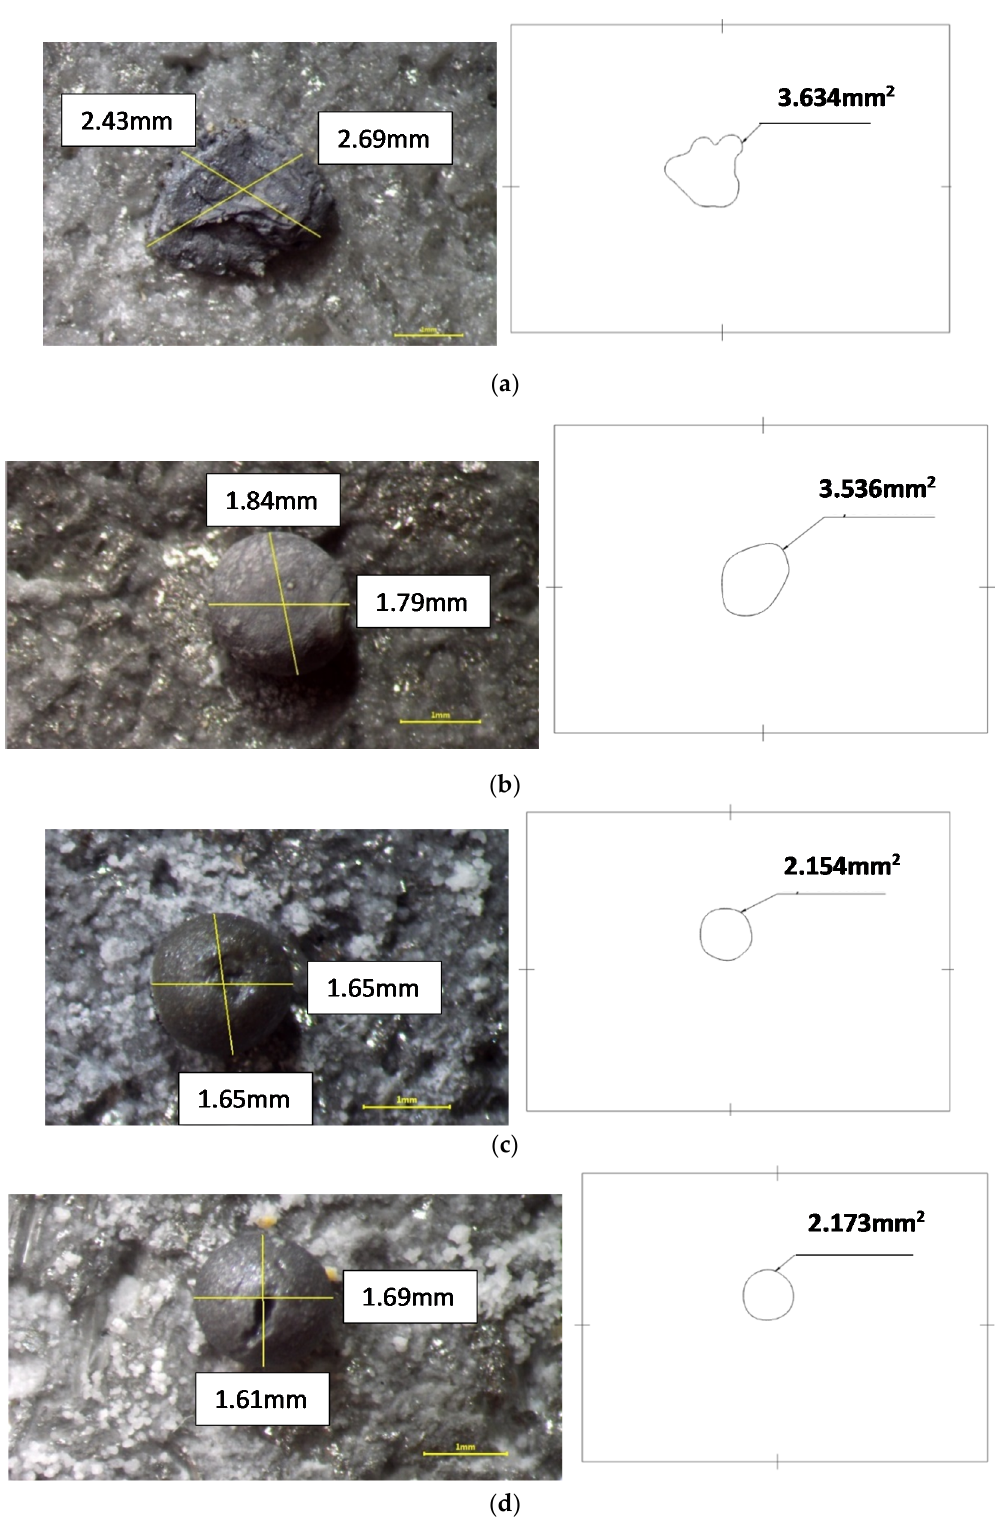
Figure 10. Preliminary tests of wettability of lead alloy with lithium: ( a ) 4%, ( b ) 8%, ( c ) 12%, ( d ) 16% [59]—view of Pb-Li drops with their dimensions and the contour of the surface area of the studied alloys.